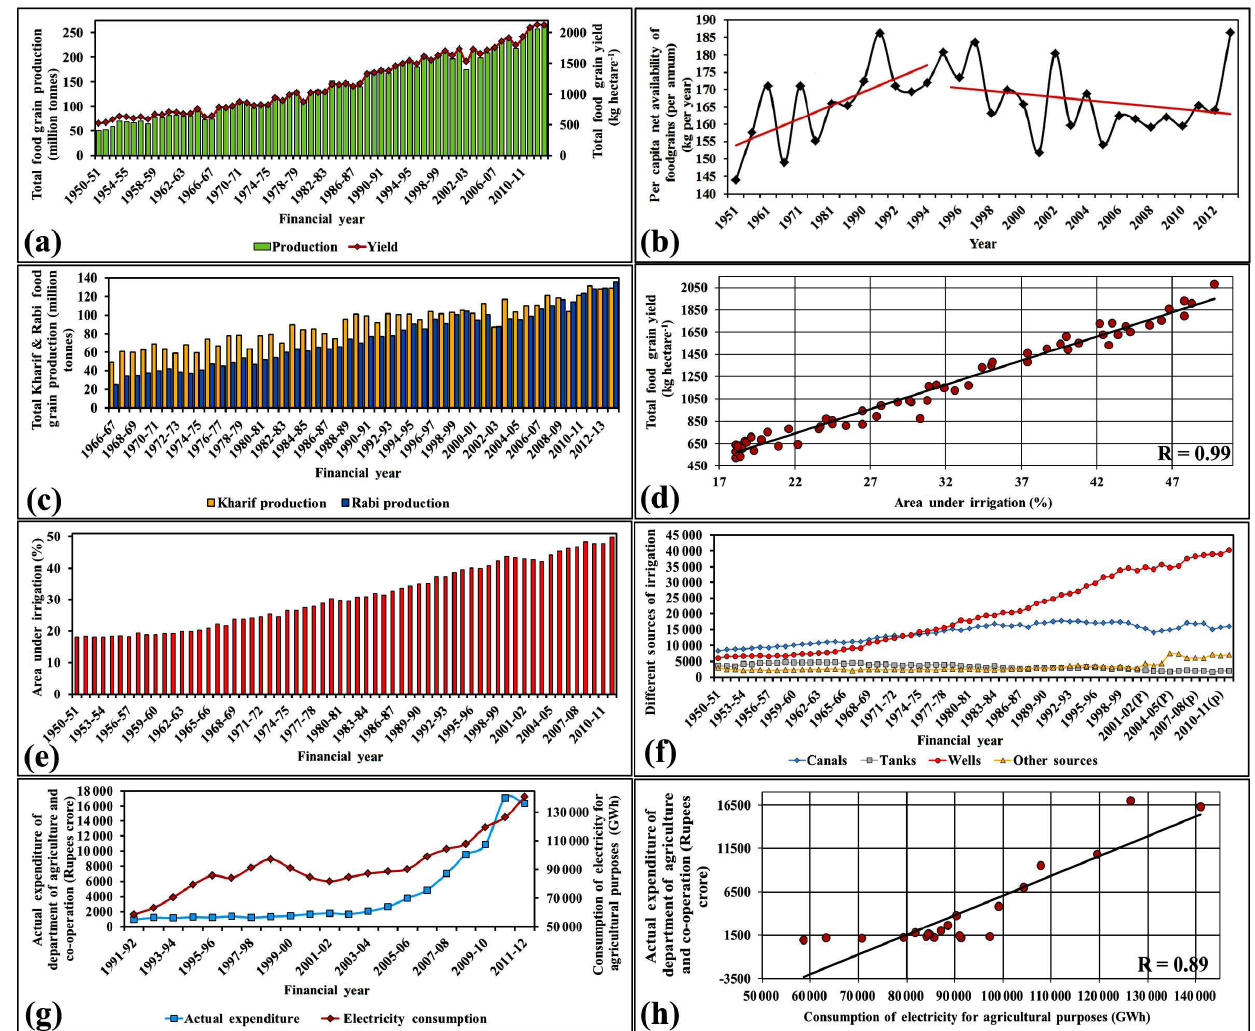
Figure 2. Overview of the Indian agricultural scenario. (a) Total food production and yield. (b) Per-capita net availability of food grains (per annum). (c) Total Kharif and Rabi food grain production. (d) Correlation between area under irrigation and total food grain yield. (e) Percent- age area under irrigation. (f) Different sources of irrigation. (g) Consumption of electricity for agricultural purposes and actual expenditure of the department of agriculture and co-operation. (h) Correlation between consumption of electricity for agricultural purposes and actual expenditure of the department of agriculture and